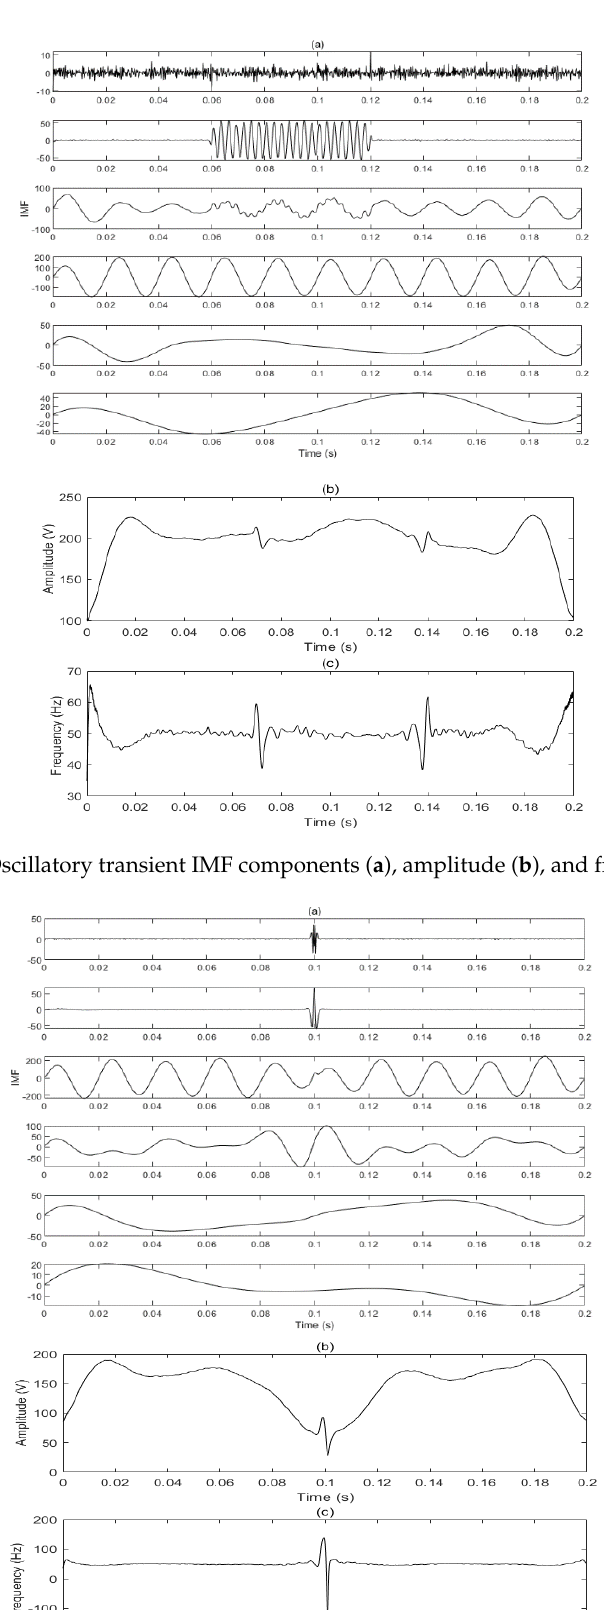
Figure 11. Voltage interruption IMF components ( a ), amplitude ( b ), and frequency ( c ).